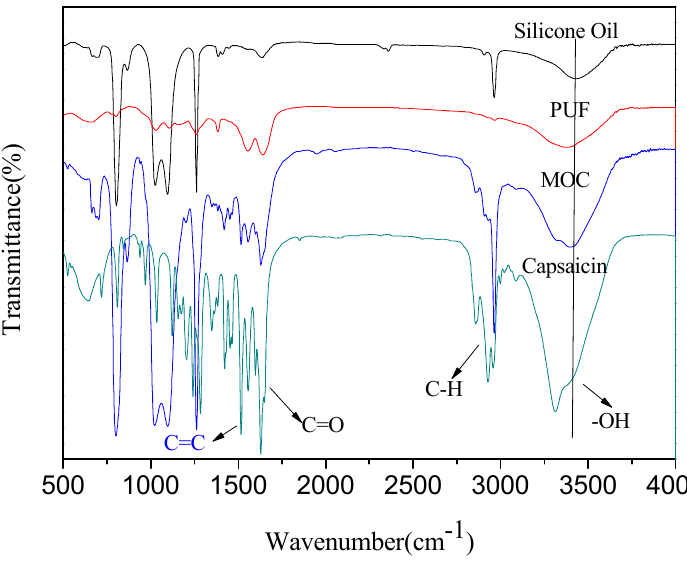
Figure 5. FTIR spectra of the pure poly(urea-formaldehyde) (PUF), the pure silicone oil, capsaicin and the synthesized MOCs.